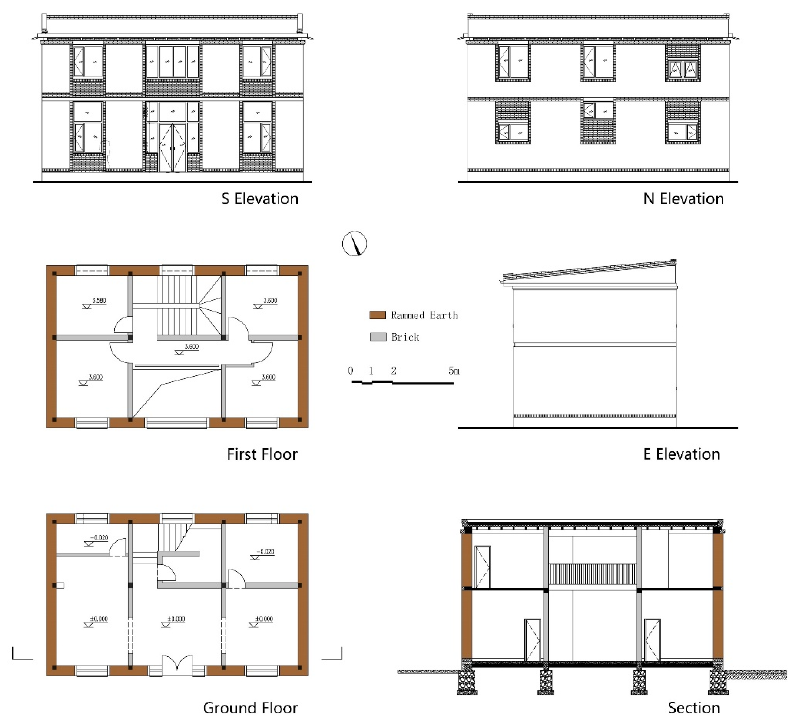
Figure 3. Metric of the building prototype.